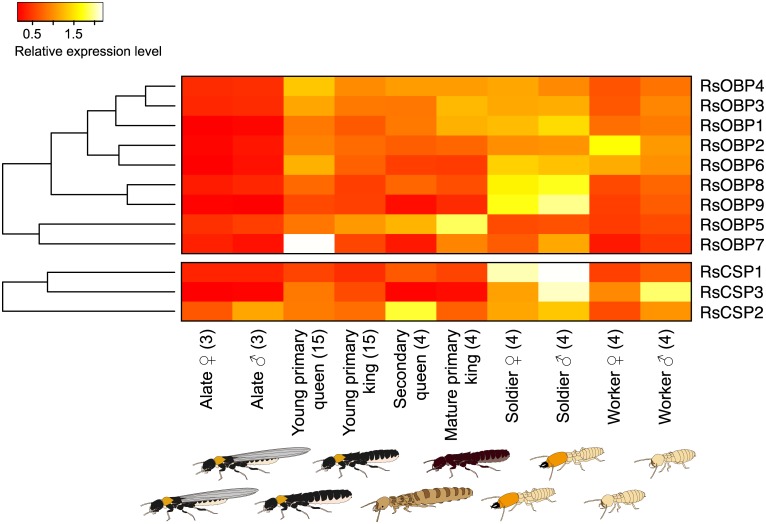
Differential expression of OBP and CSP among castes.The heatmaps exhibit the differential expression of nine OBPs and three CSPs transcripts among termite castes. Abbreviations are referred to in Fig 3. Relative expression level indicates the mean CPM, ranging from red (scaled expression of 0) to white (scaled expression of 2). Tree at the left correspond to hierarchical clustering of cluster-averaged expression.